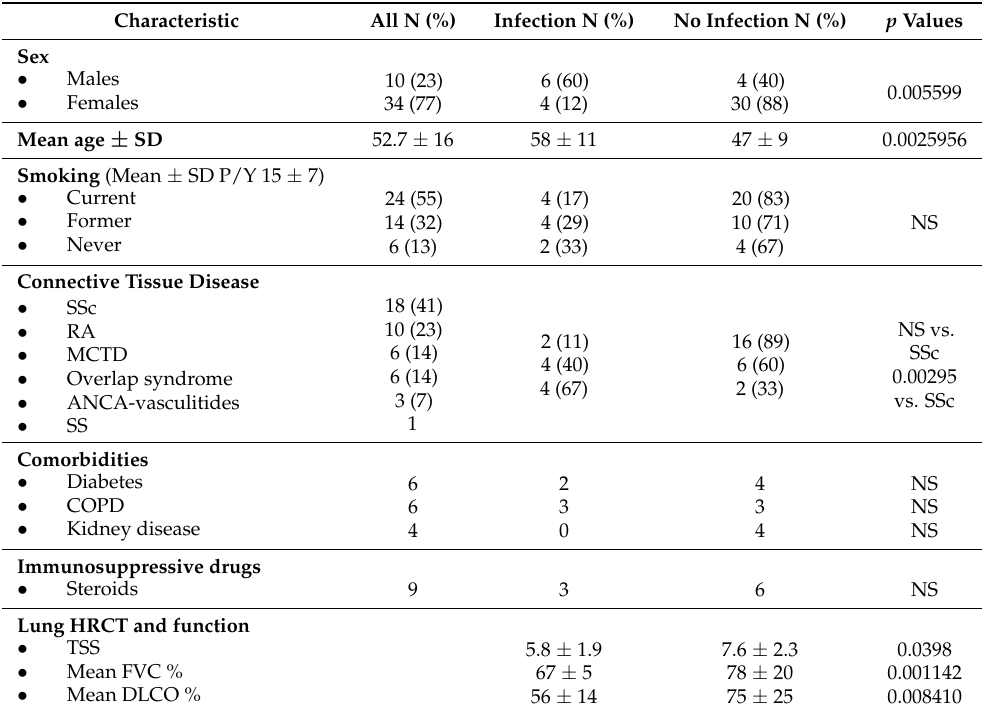
Table 1. Socio-demographic, lifestyle, and clinical characteristics of 44 CTD-ILD patients, examined in univariate analysis.